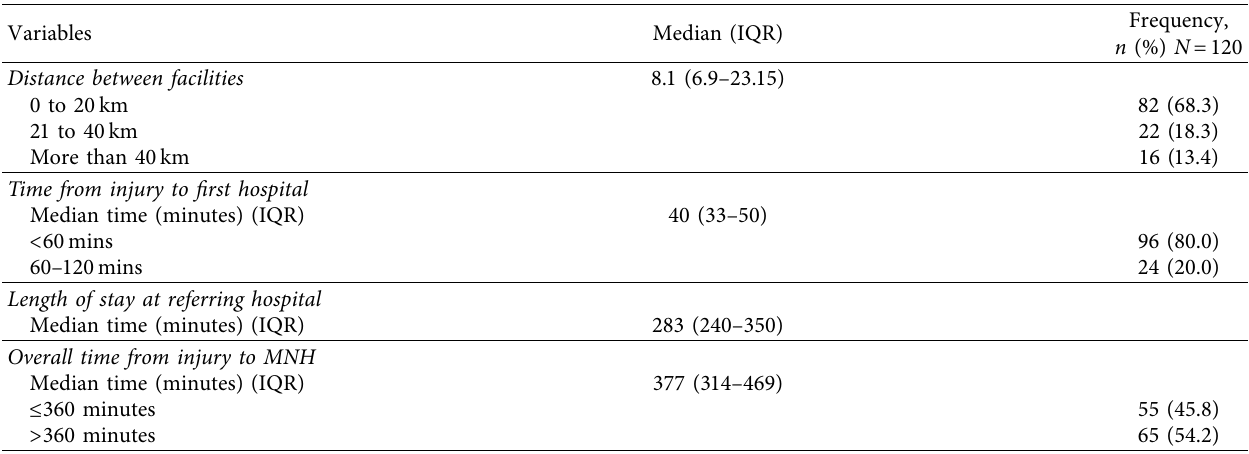
Table 2: Referral characteristics and timing of presentation of referral polytrauma patients who presented to the EMD-MNH, Dar es Salaam, Tanzania.